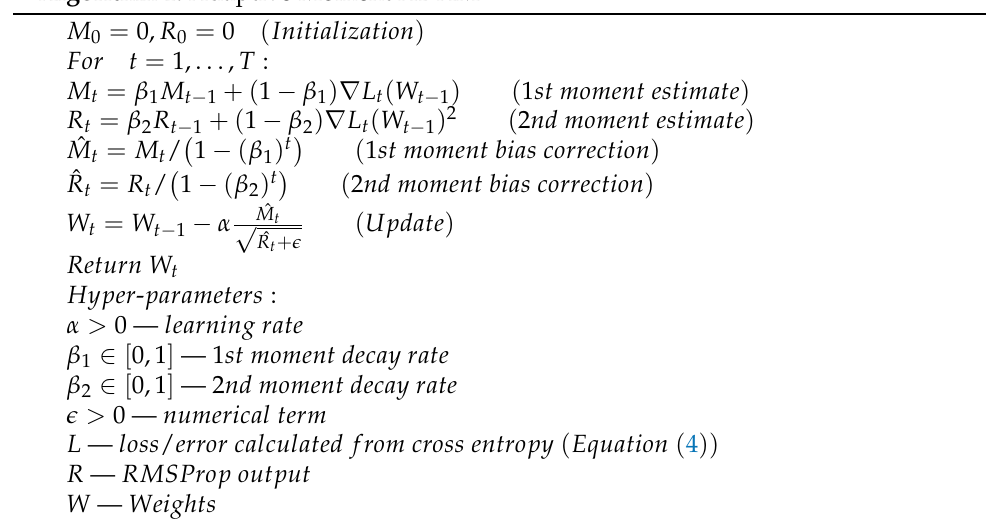
Algorithm 1: Adaptive Moment